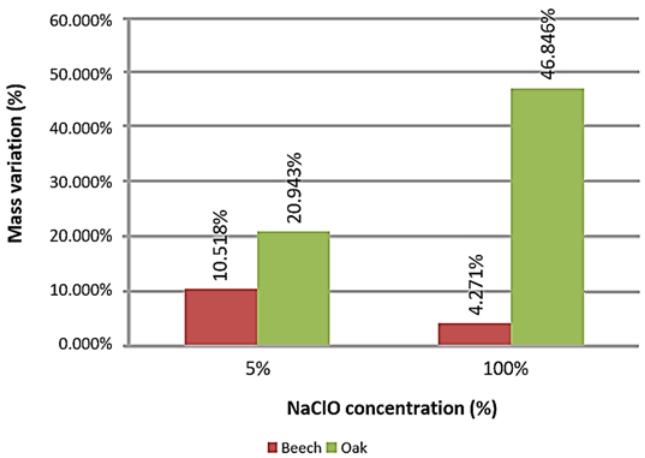
Figure 8. Mass variation of the large samples after three months of immersion